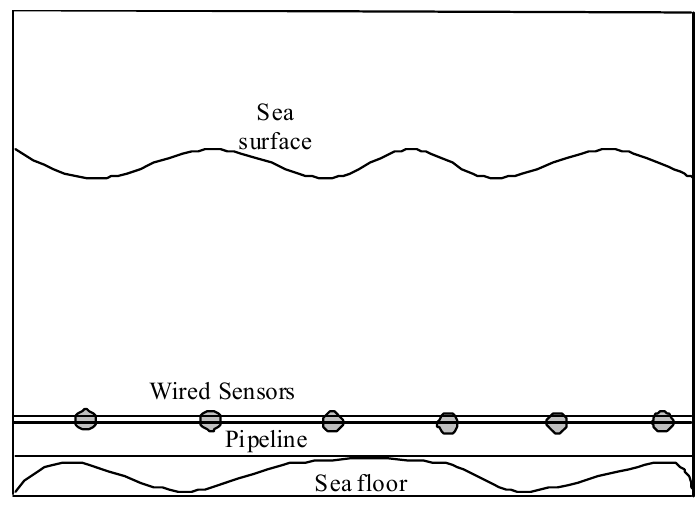
Figure 1. Underwater wired sensor